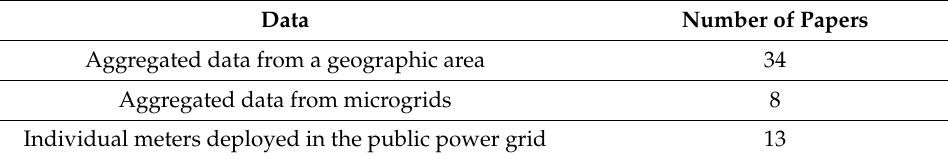
Table 4. Origin of load time-series